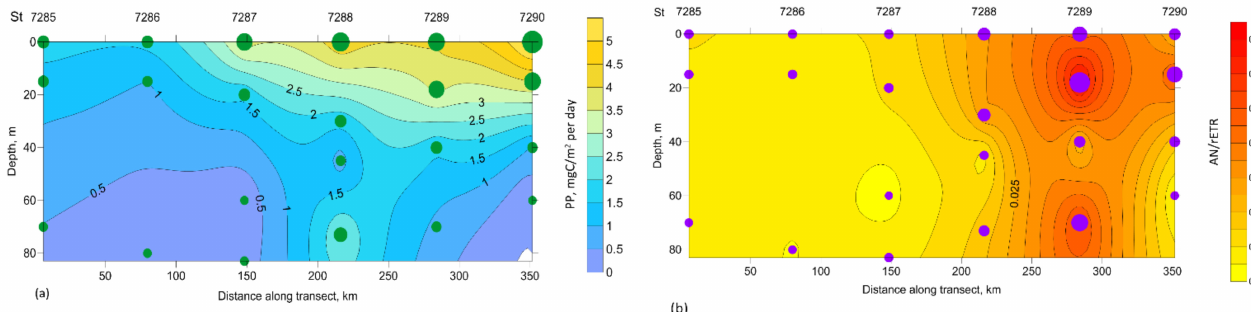
Figure 13. Spatial distribution of primary production ( a ) and photosynthetic efficiency ( b ) of phy- toplankton in the euphotic layer. Circles indicate the location of sampling points, and their size is proportional to the values of the corresponding